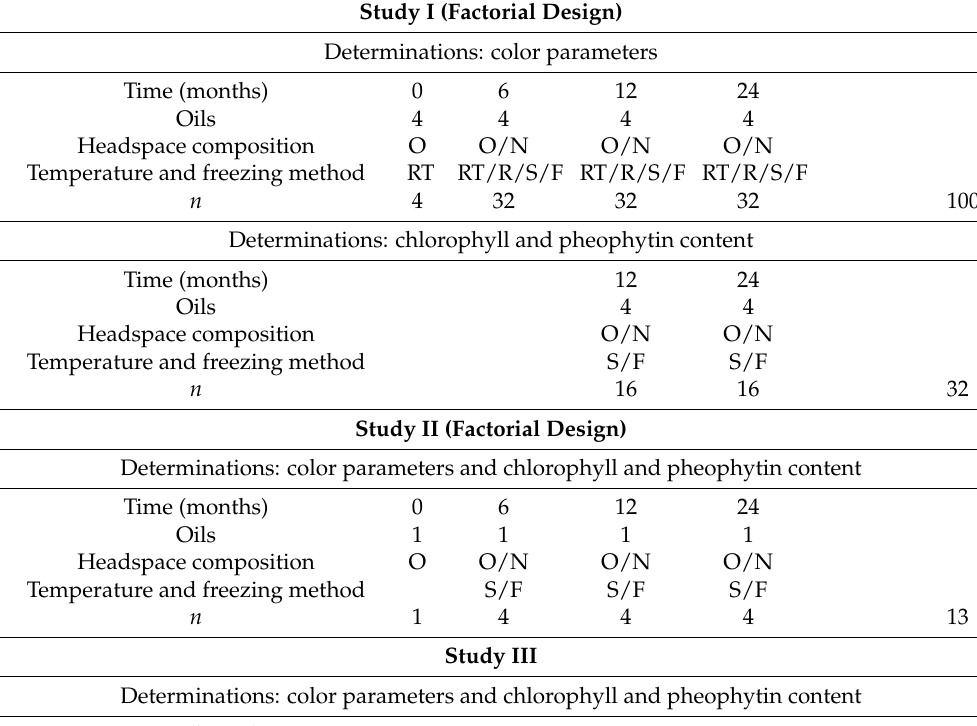
Table 1. Experimental designs of studies I, II, III and